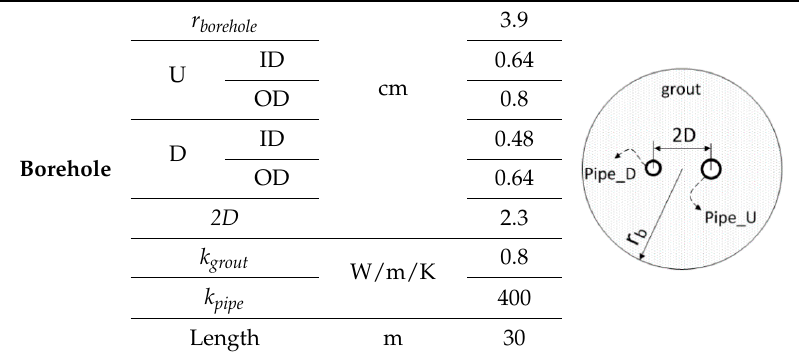
Table 3. Ground thermal properties.